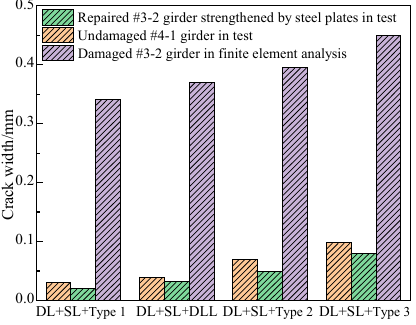
Figure 26. Crack width comparison. Table 6. Safety coefficient for different types of